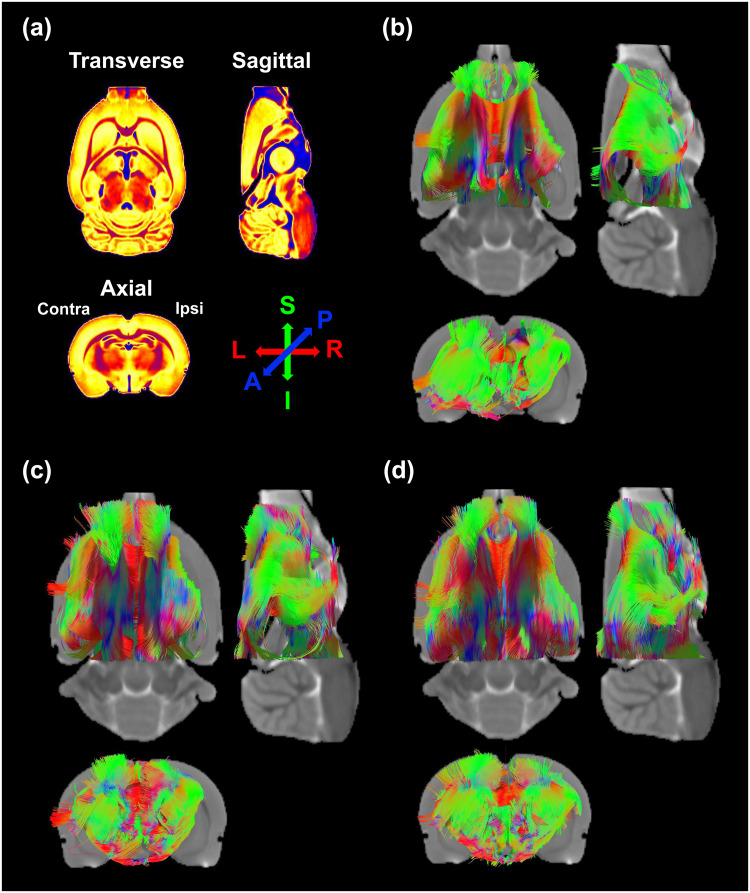
Diffusion tensor tractography images.(a) Imaging plane and color information. Color indicates predominant orientation of reconstructed fiber tracts (red for left-right, green for superior-inferior, and blue for anterior-posterior). Representative fiber tractography from the contra-/ipsilesional ROIs at 5 weeks after treatment with (b) PBS-only, (c) FBS-hMSCs, and (d) SS-hMSCs.